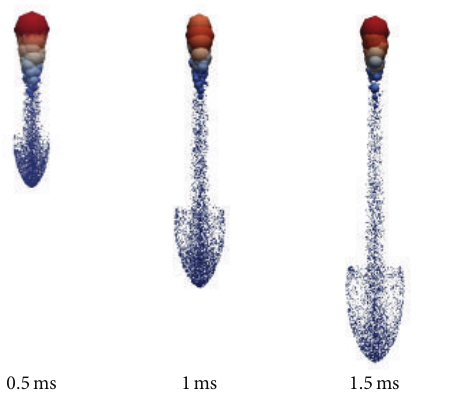
Figure 12: Time history of spray formation of B15 at injection pressure of 1000bar.